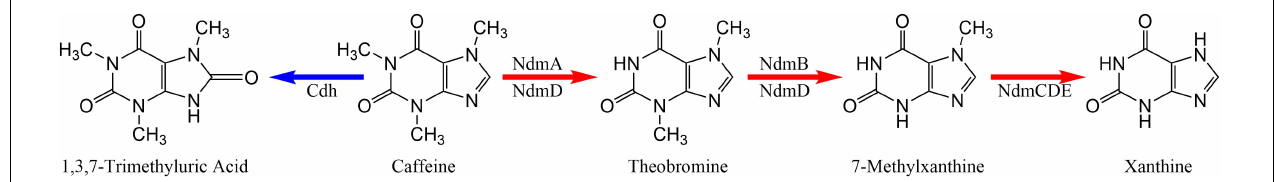
FIGURE 1 | Metabolic pathways for caffeine degradation by bacteria. N-demethylation is indicated by red arrows. C-8 oxidation is indicated by the blue arrow.